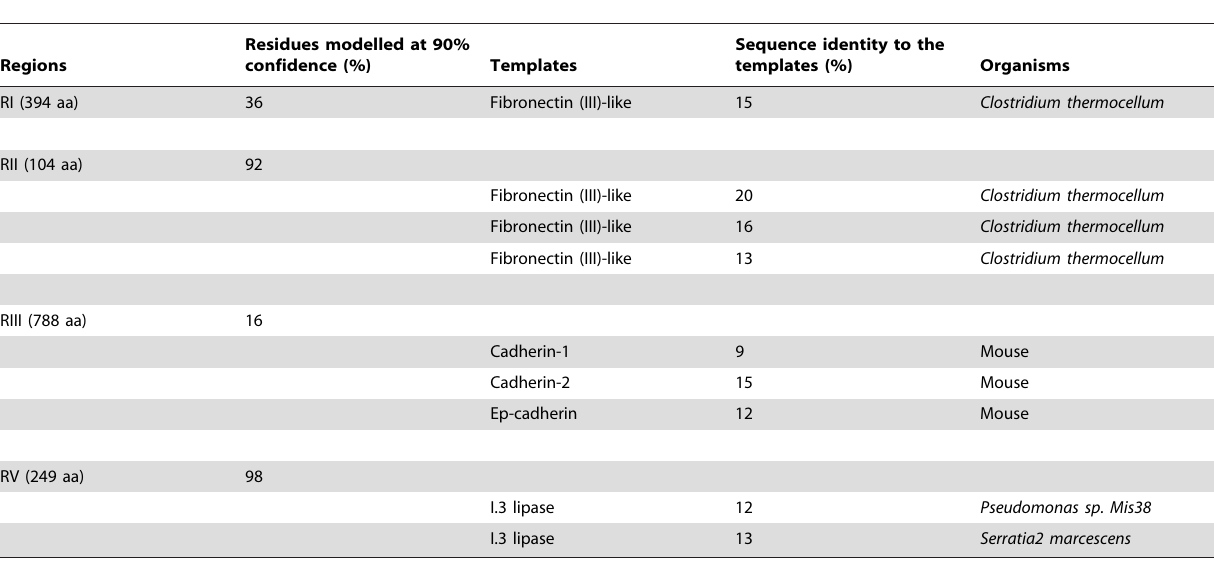
Residues modelled at 90% confidence (%)